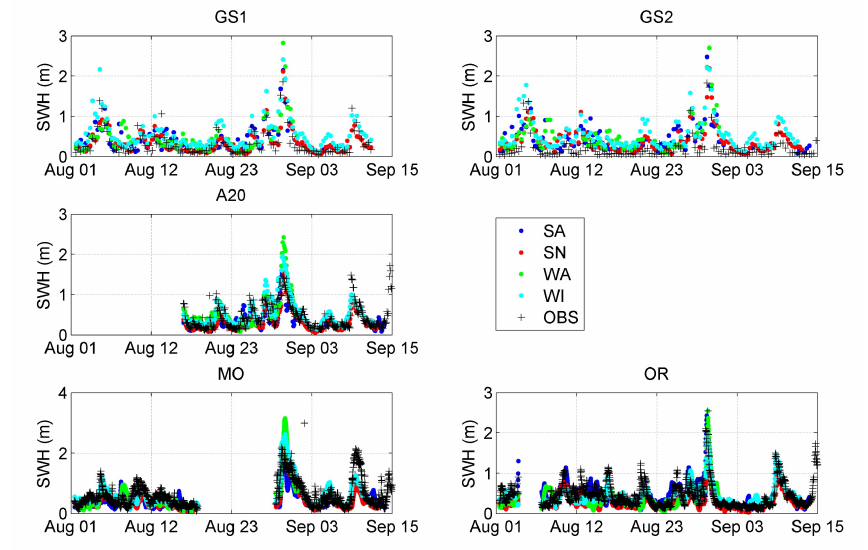
Fig. 5. Data at the survey stations and interpolated models outputs during DART06B.